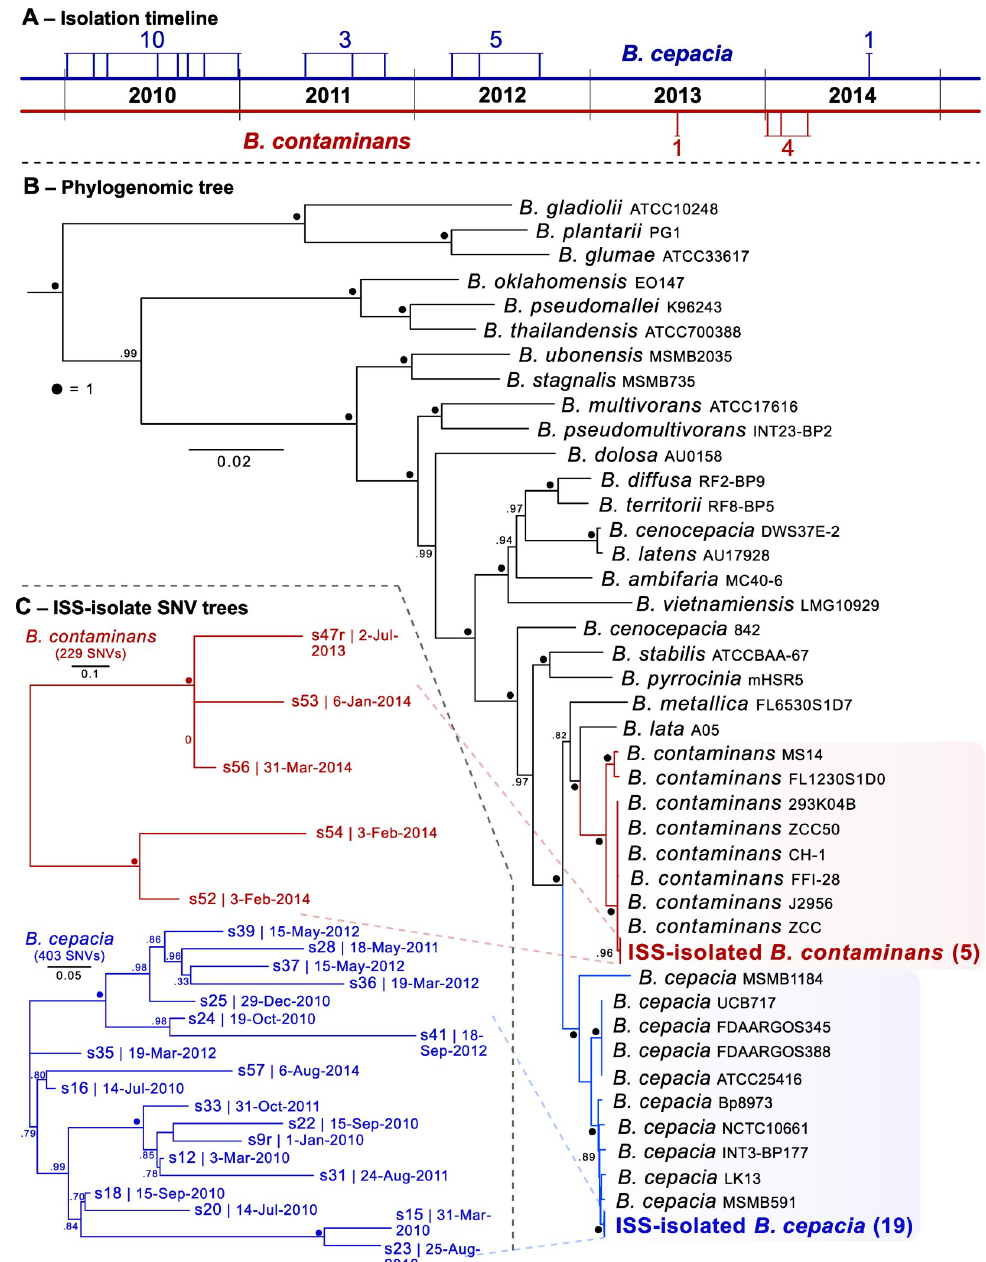
Fig 1. Isolate overview. (A) Isolation timeline (dates with multiple isolates a represented by a single line). (B) Estimated maximum-likelihood phylogenomic tree based on aligned and concatenated amino acid sequences of 203 single-copy genes designed for targeting Betaproteobacteria–rooted with Ralstonia pickettii 12J (GCF_000020205.1). Numbers in parentheses indicate number of isolates in that clade. (C) ISS-derived isolate SNV trees for each Burkholderia species. Date of isolation follows the unique identifiers. Those with an “r” represent the genome used as the reference for that SNV tree. Total aligned proportion of all genomes used in generating the SNV tree was greater than 70% in both species.